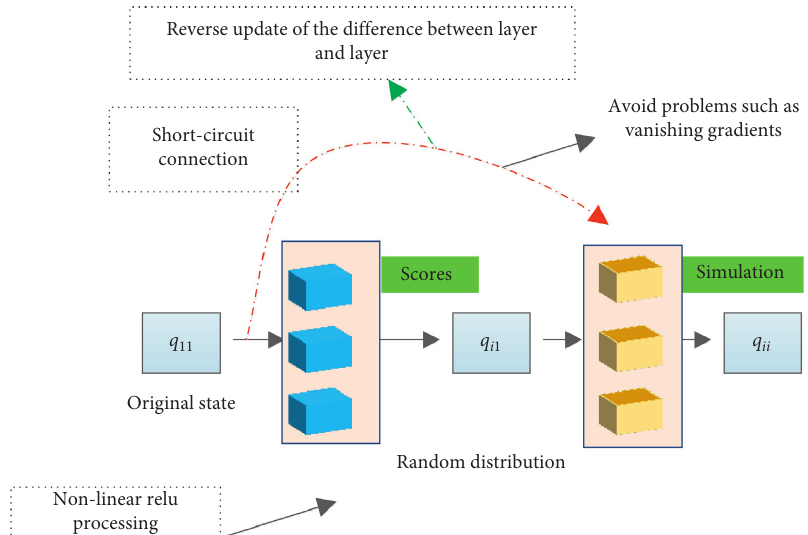
Figure 1: Illustration of the algorithm for retrieving the relevance of text content to the